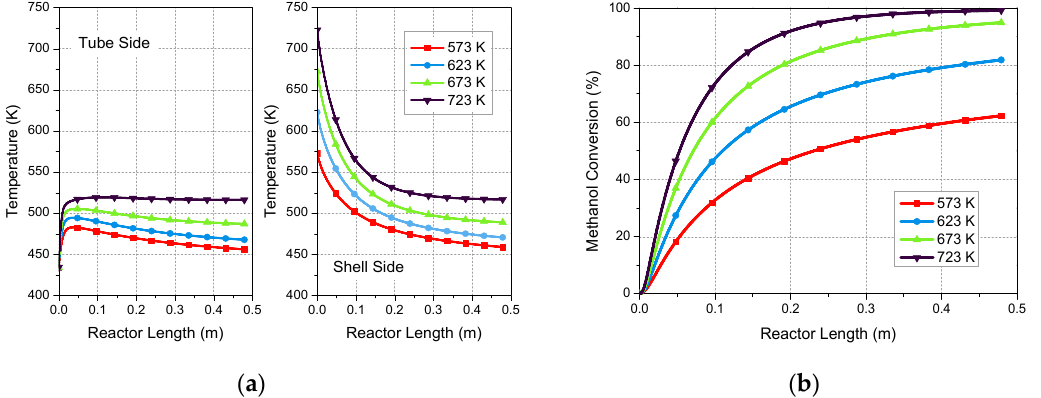
Figure 9. The effect of the inlet temperature of thermal air ranging from 573 to 723 K on ( a ) the temperature profile of both tube side and shell side, and ( b ) the methanol conversion along the length of reactor.